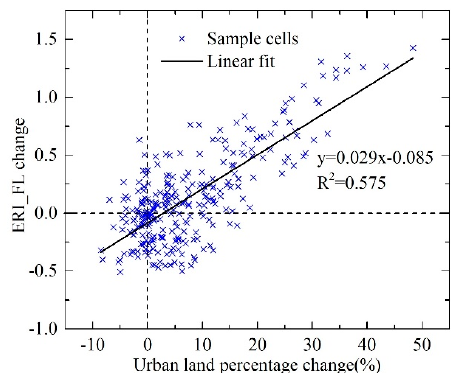
Figure 8. Spatial distributions of ERI_FL for 2003 and 2017, and ERI_FL change from 2003 to 2017.